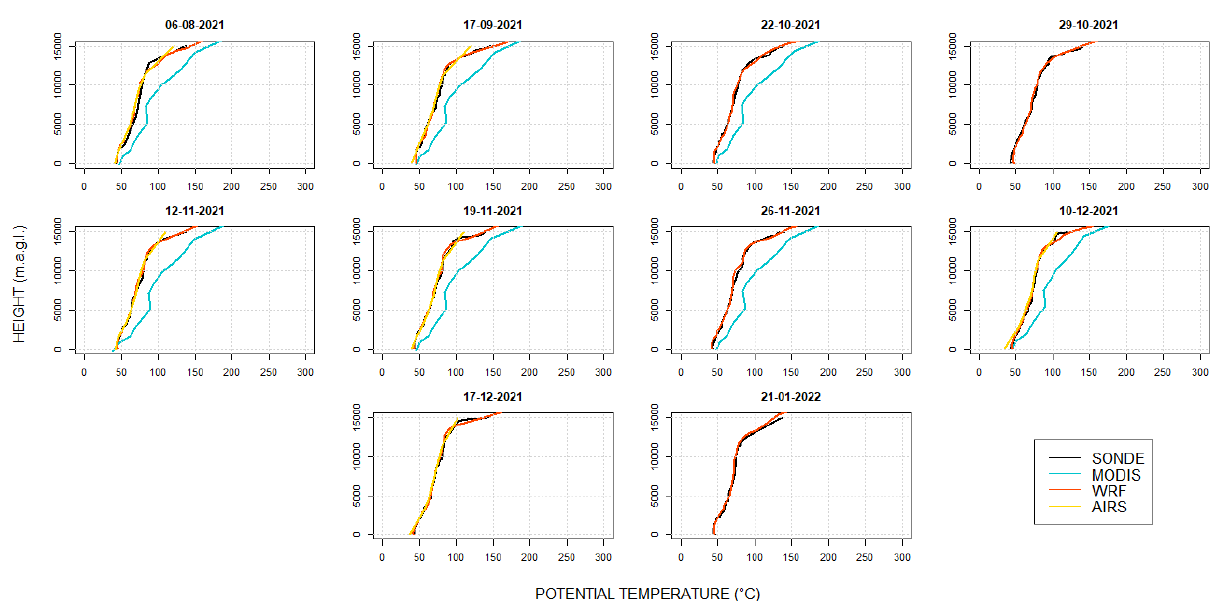
Figure A4. Potential temperature profiles measured with radiosonde (black), drone (green), MODIS (sky-blue), AIRS (yellow), and WRF (orange) up to 15,000 magl. for 10 measurement events.